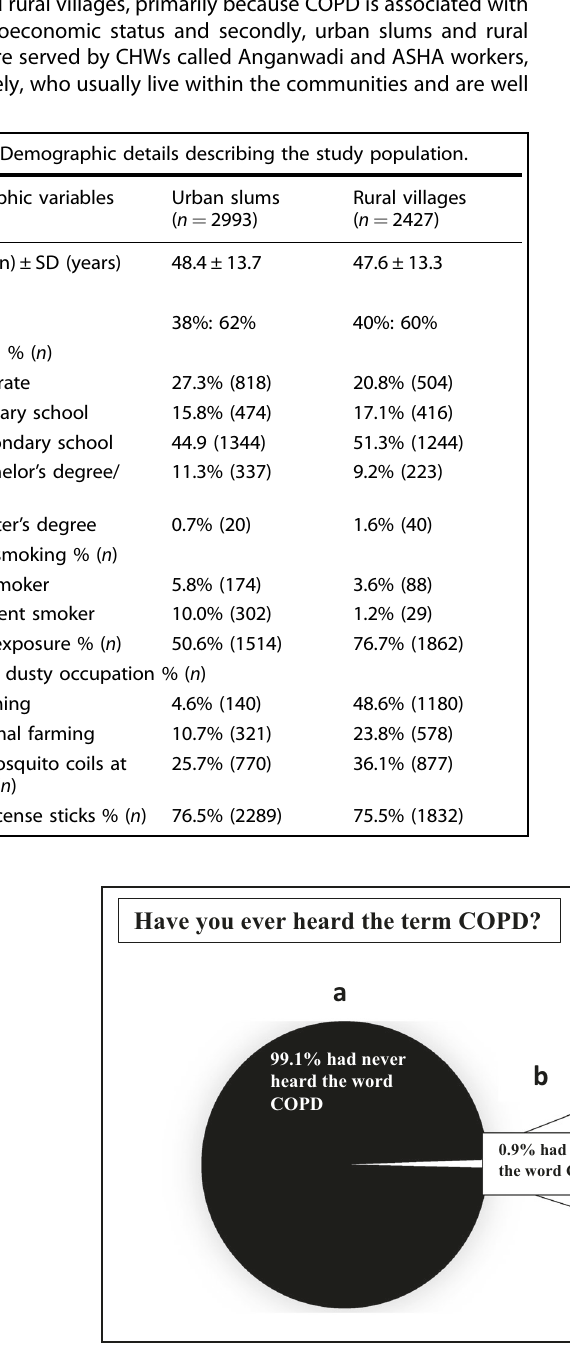
Fig. 1 COPD awareness: “ Have you ever heard the term COPD? Do you know what COPD means? ” and “ Which organ is affected in COPD? ” Answers given by the 0.9% who had heard the word COPD. a Percentage of people who have never heard the term COPD. b Percentage of people who have heard the term COPD. c Responses to the question “ Which organ is affected in COPD? ” by the study participants who had heard the term COPD